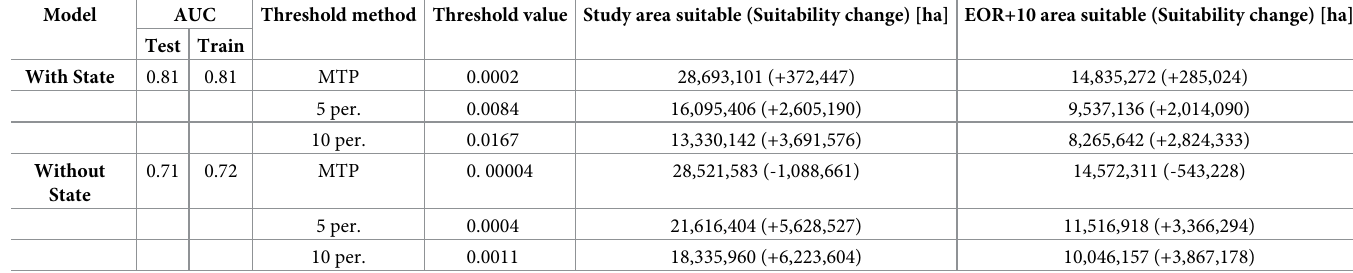
Table 2. Metrics comparing area of suitable habitat modeled with and without state as a